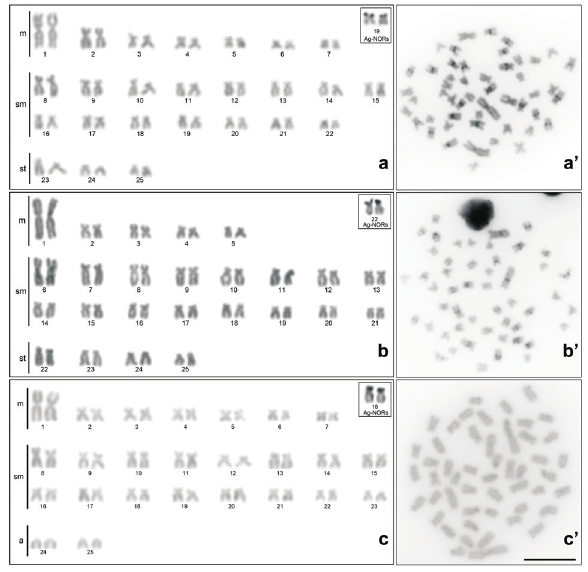
Figure 2 - Karyotypes stained by 5% Giemsa ( a , b , and c ) and metaphases after C-banding ( a’ , b’ , and c’ ) of (a) M . cosmops , (b) Moenkhausia sp. n., and (c) M . nigromarginata . The Ag-NORs are shown in the box. Scale bar = 10 (cid:2)